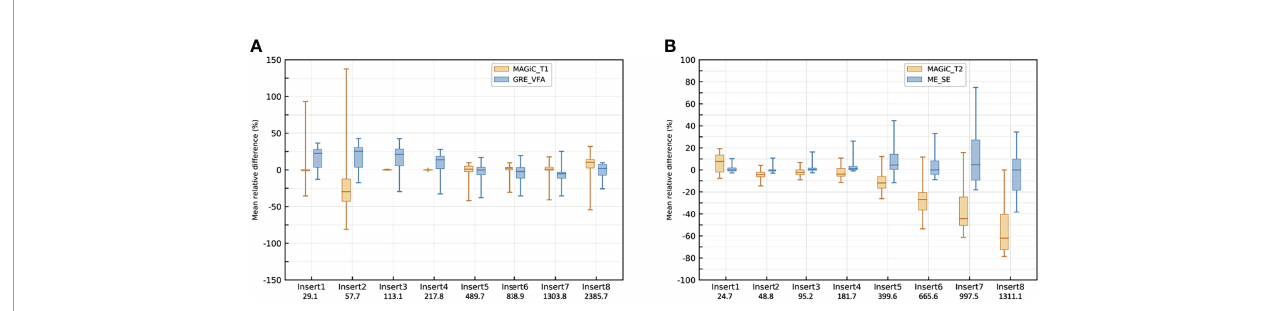
FIGURE 5 | Box plot of the repeated measurements ( n = 14) with the head and neck unit (HNU) coil of T 1 mappings for the MAGiC ® sequence and gradient echo with variable fl ip angle (GRE-VFA) (A) and T 2 mappings for the MAGiC ® sequence and multi-echo spin echo (ME-SE) (B) . The values of the relative differences (in percent) are given with the associated medians, fi rst and third quartiles, and the maximum and